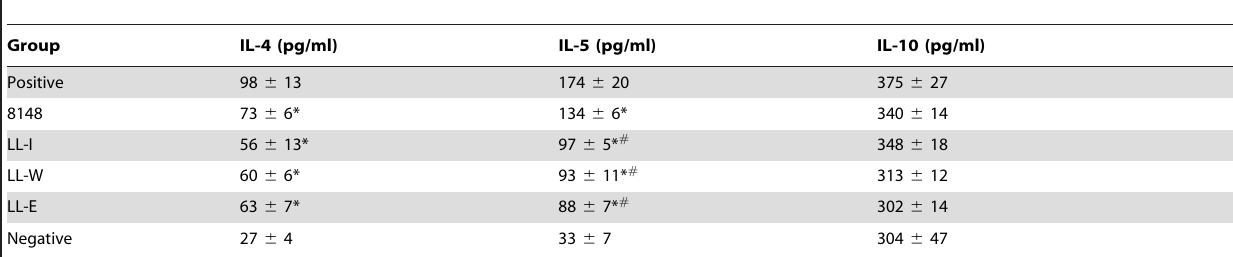
Table 4. Cytokine production in bronchoalveolar lavage fluid.